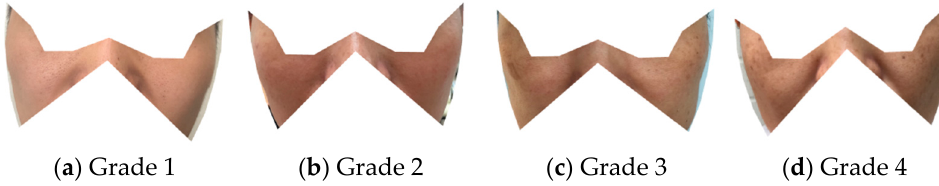
Figure 7. Examples of the four grades of cheek speckles (regions are similar to Figure 2d).